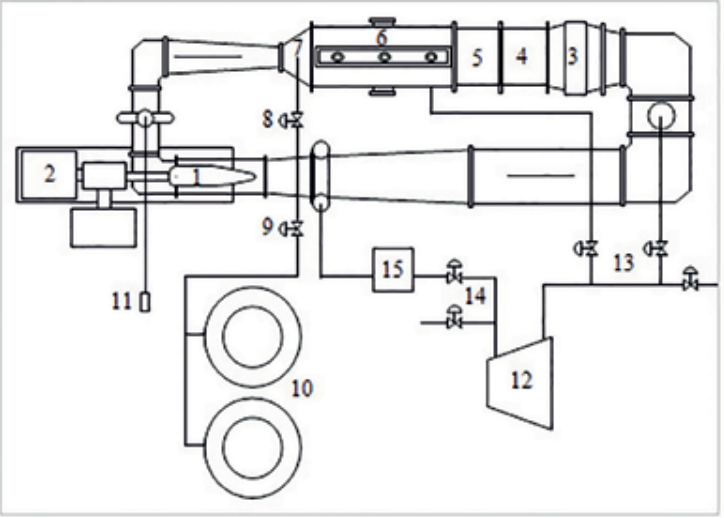
Figure 3. Diagram of TTP installation, with its main components: (1) main compressor; (2) electric motor; (3) cooler; (4) stilling chamber; (5) contraction; (6) plenum chamber, which involves the test section; (7) injectors; (8) injector system control valve; (9) safety valve; (10) reservoirs; (11) exhaustion valve; (12) auxiliary compressor; (13) admission valves; (14) discharge valves; and (15) dryer.